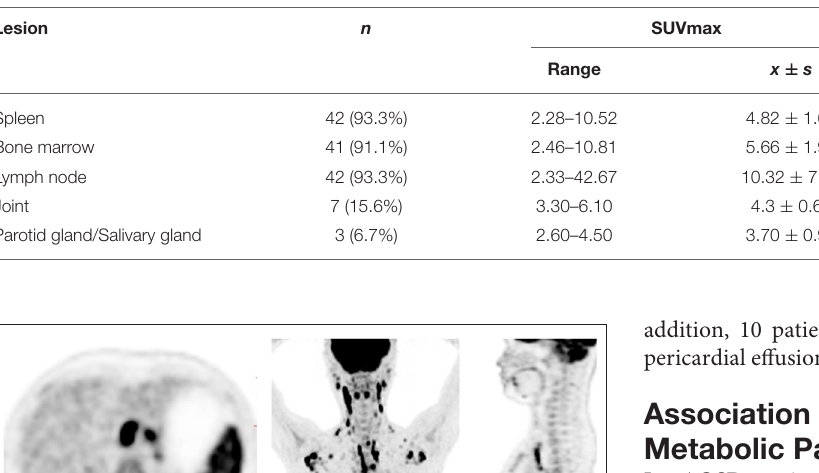
TABLE 2 | 18 F-FDG uptakes in AOSD patients.